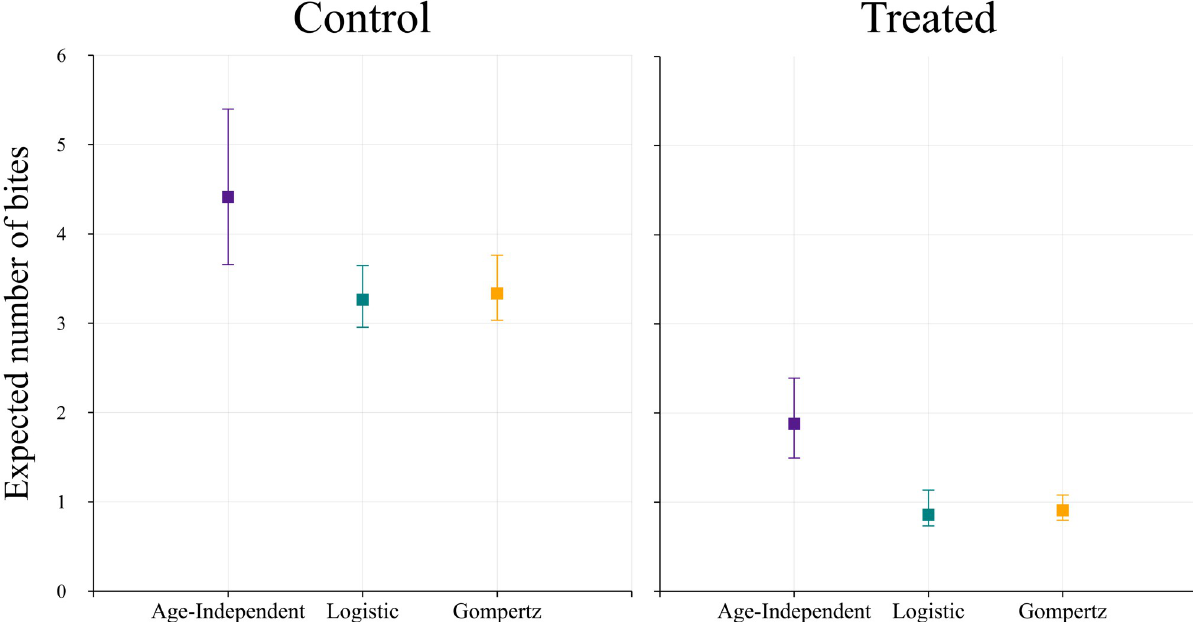
Fig 9. The expected number of infectious bites a mosquito will take in its lifetime. The error bars represent the 95% confidence interval due to the error propagated from the parameter estimates through Monte Carlo simulations.